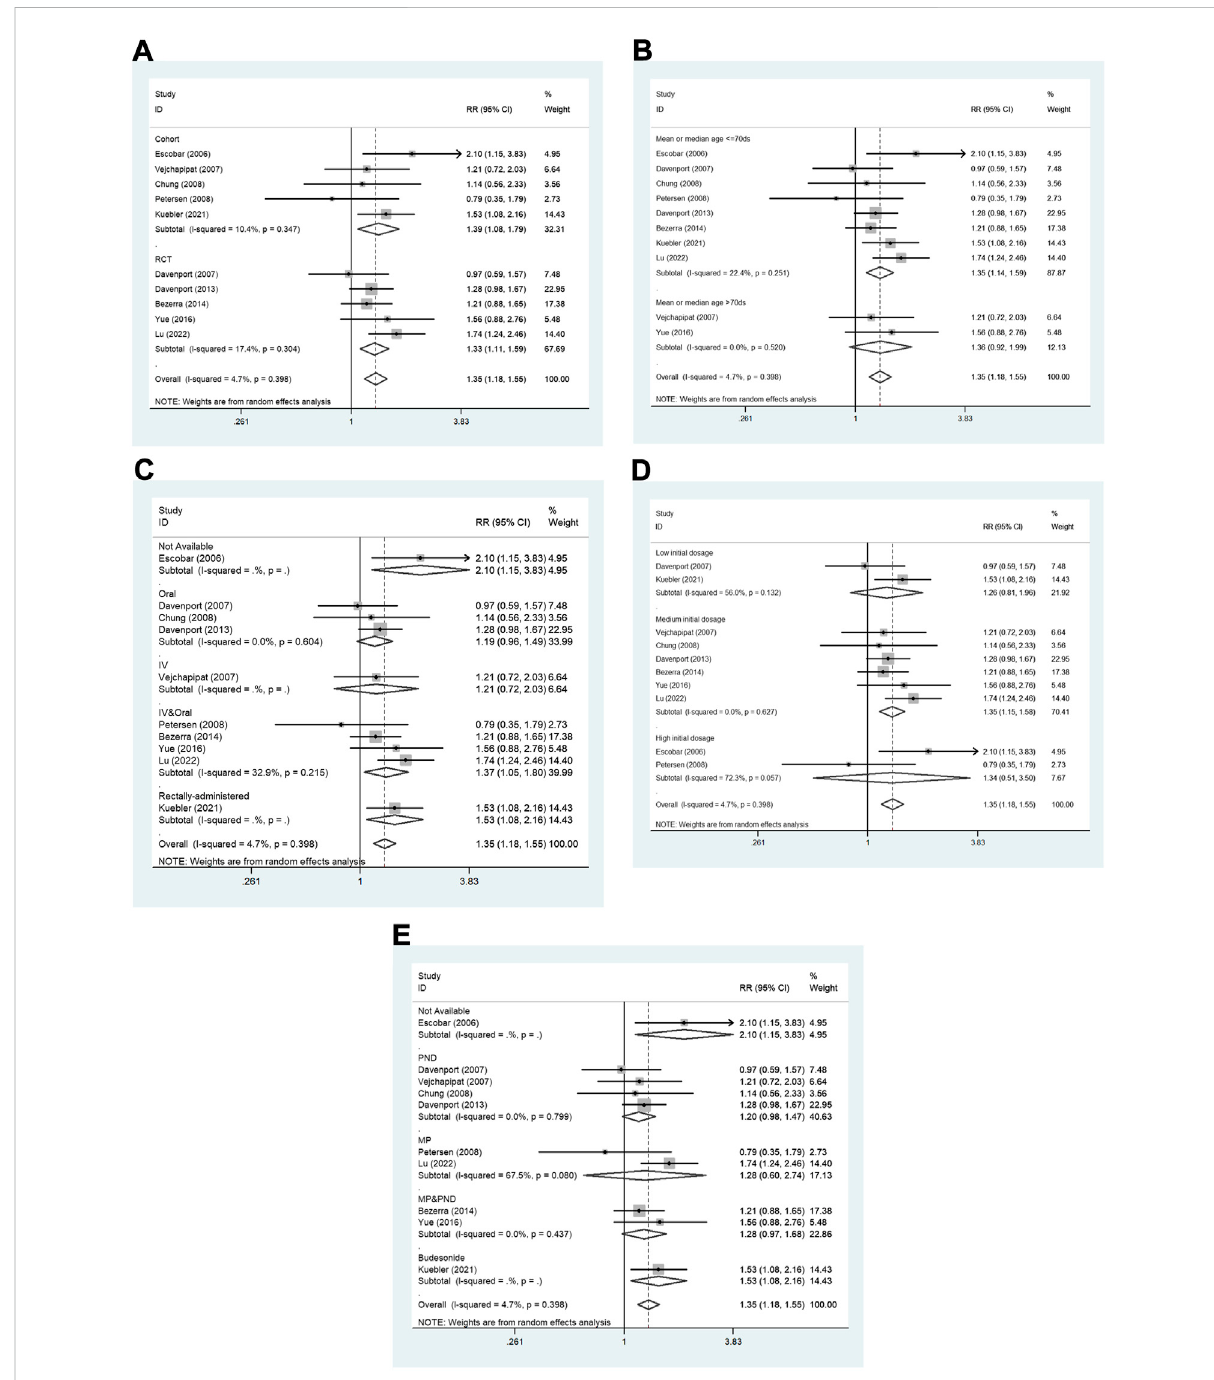
FIGURE 4 The subgroup analyses for the assessment of JCR at 6 months. (A) Study design. (B) Age at KP. (C) Administration method. (D) Initial dosage. (E) Steroid type. JCR, jaundice clearance rate; IV, intravenous; MP, methylprednisolone; PND, prednisone. RCT, randomized controlled